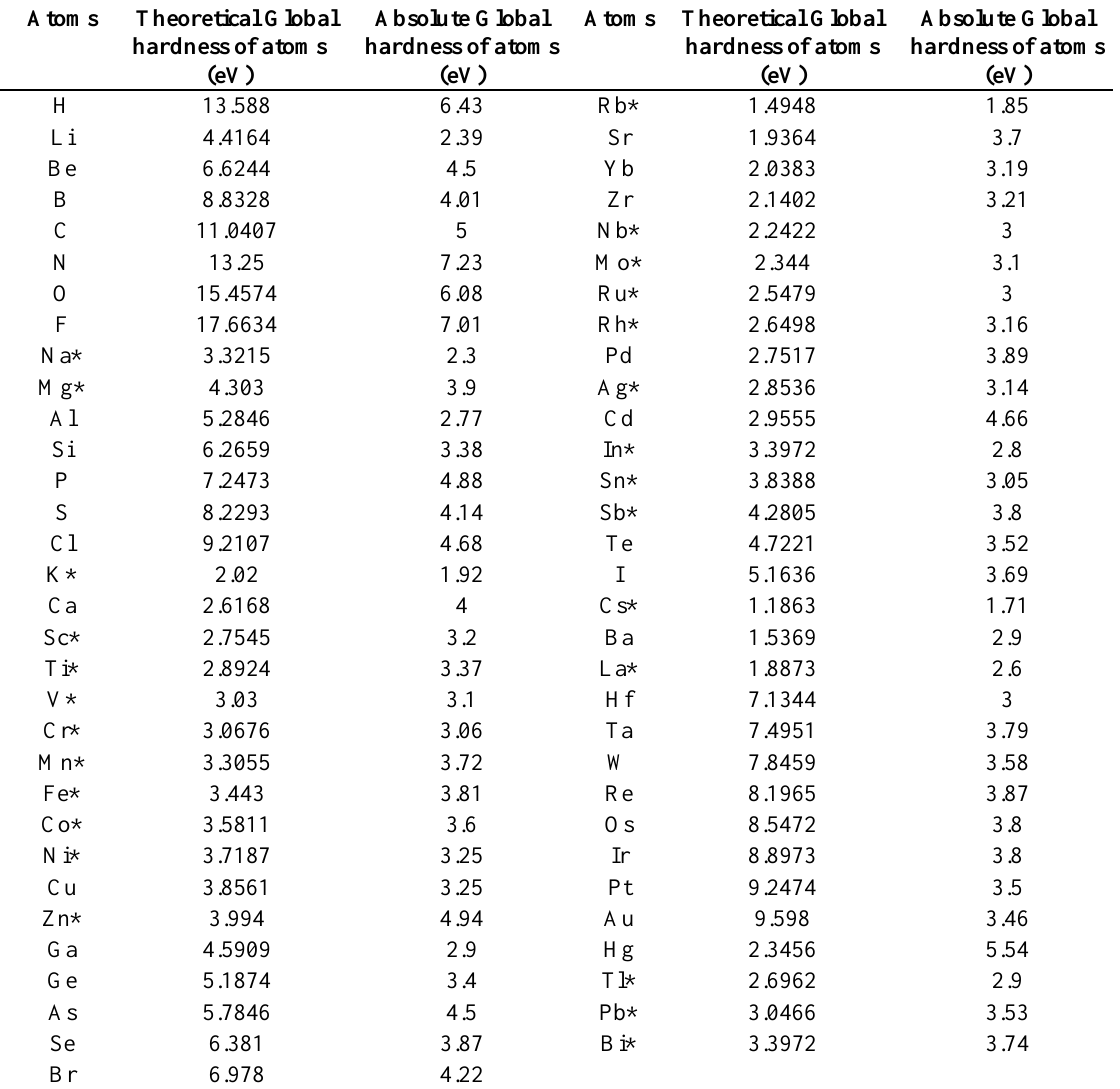
Table 9. Comparative study of theoretical and absolute global hardness (atoms having theoretical hardness close within 0.1–1.0 eV to the experimental are given